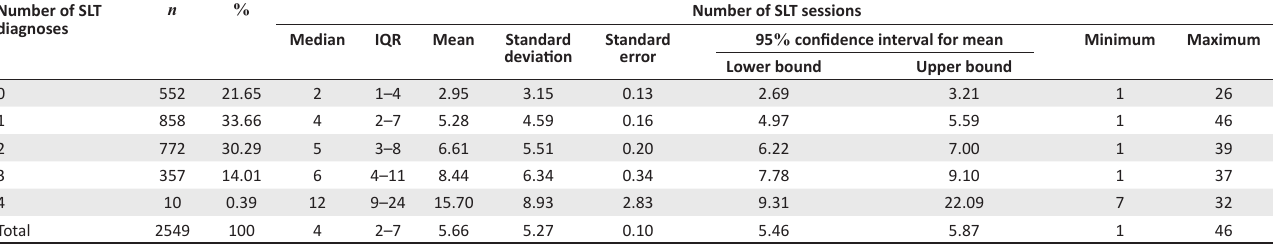
TABLE 5: Co-occurring speech-language therapy diagnoses and number of speech-language therapy sessions. Number of SLT